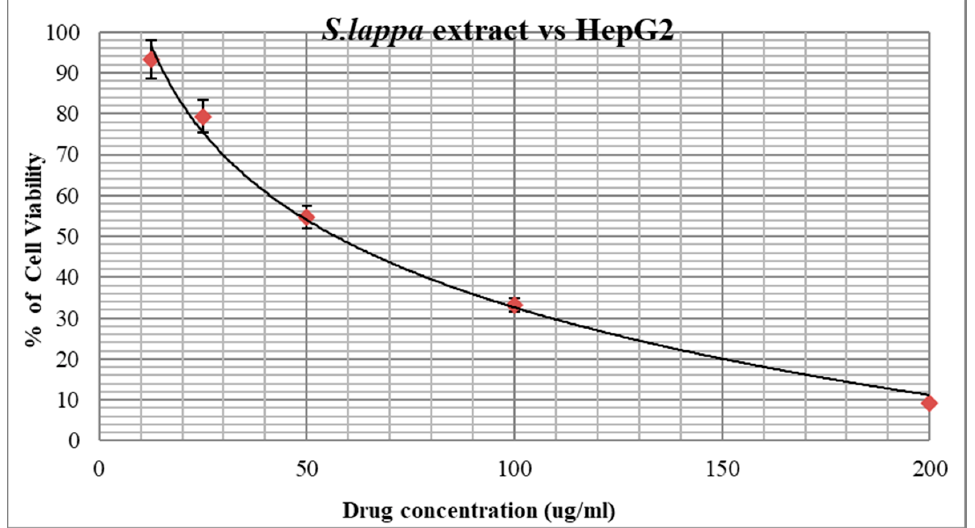
Figure 6. Graph showing the percentage cell viability of root extract against HepG2 cell line after 24 h. 3.5. Apoptosis Assessment with Acridine Orange–Ethidium Bromide Double Staining Assay of S. lappa N-Butanol Root Extract